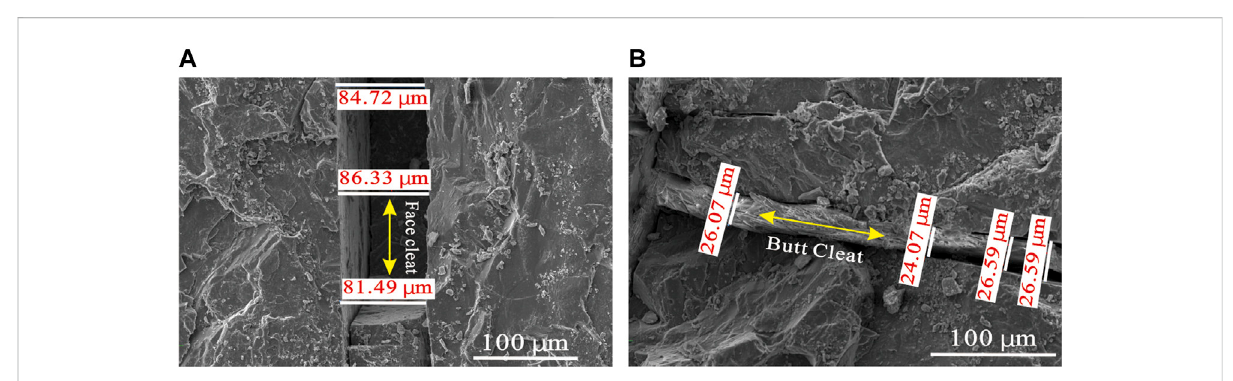
FIGURE 5 Mineralized face cleat and butt cleat: (A) , face cleat; (B) butt cleat.